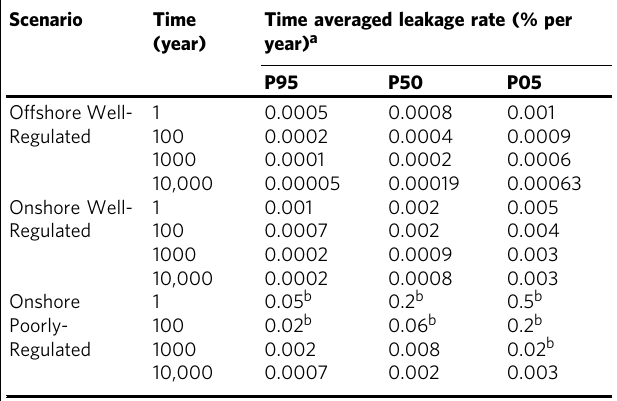
Table 2 Time averaged leakage rates of the three scenarios